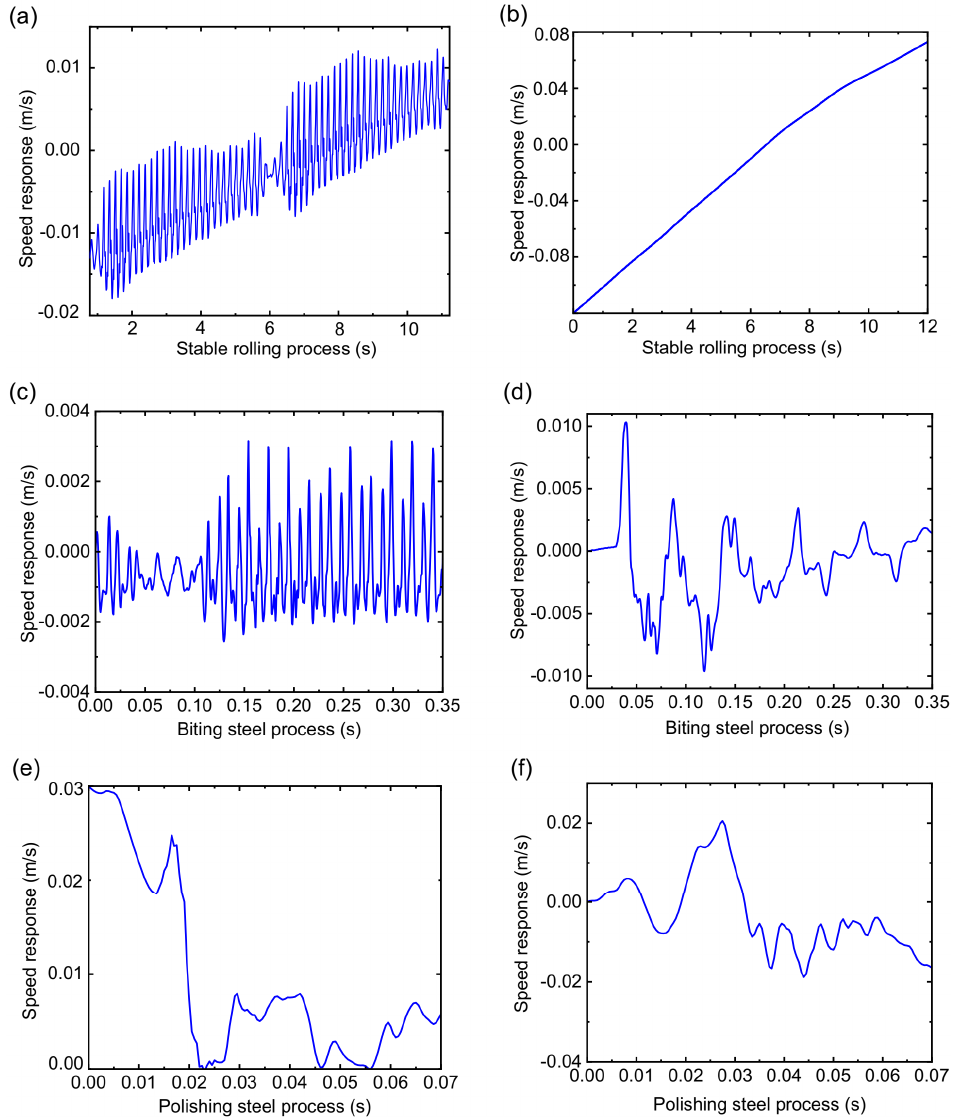
Figure 10. Transient speed response of the system: ( a ) stable rolling process of the 1.6 mm, ( b ) stable rolling process of the 3.2 mm, ( c ) biting steel process of the 1.6 mm, ( d ) biting steel process of the 3.2 mm, ( e ) polishing steel process of the 1.6 mm, and ( f ) polishing steel process of the 3.2 mm.